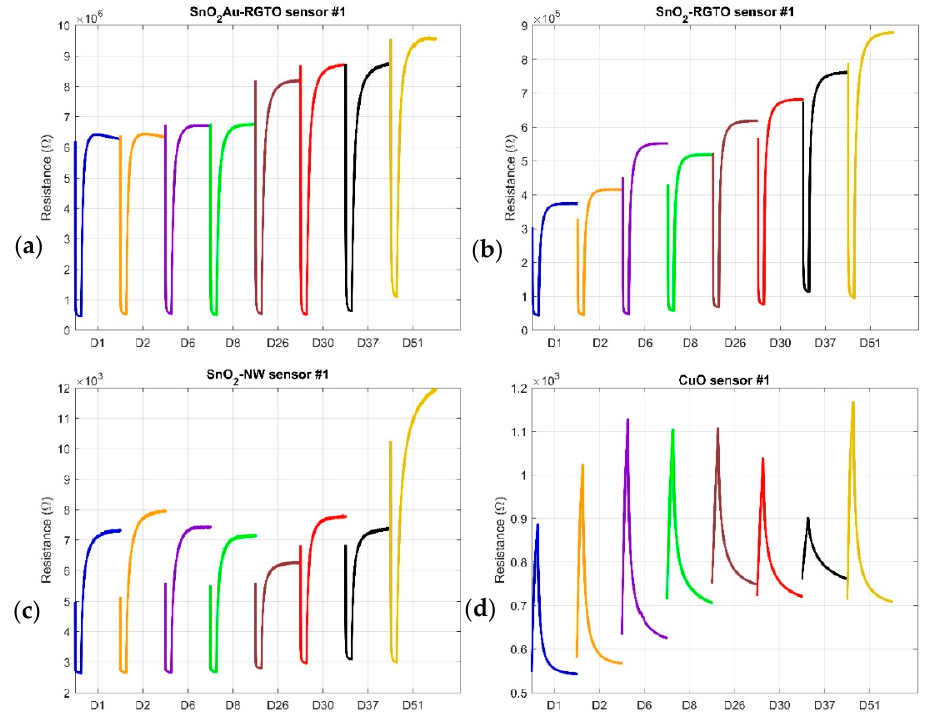
Figure 1. Outputs from all sensors’ typologies to 300 ppm of ethanol, from day 1 to day 51. Each signal is the mean of the ten signals acquired the same day. ( a ) SnO 2 Au RGTO sensor #1; ( b ) SnO 2 RGTO sensor #1; ( c ) SnO 2 NW sensor #1; ( d ) CuO sensor #1.